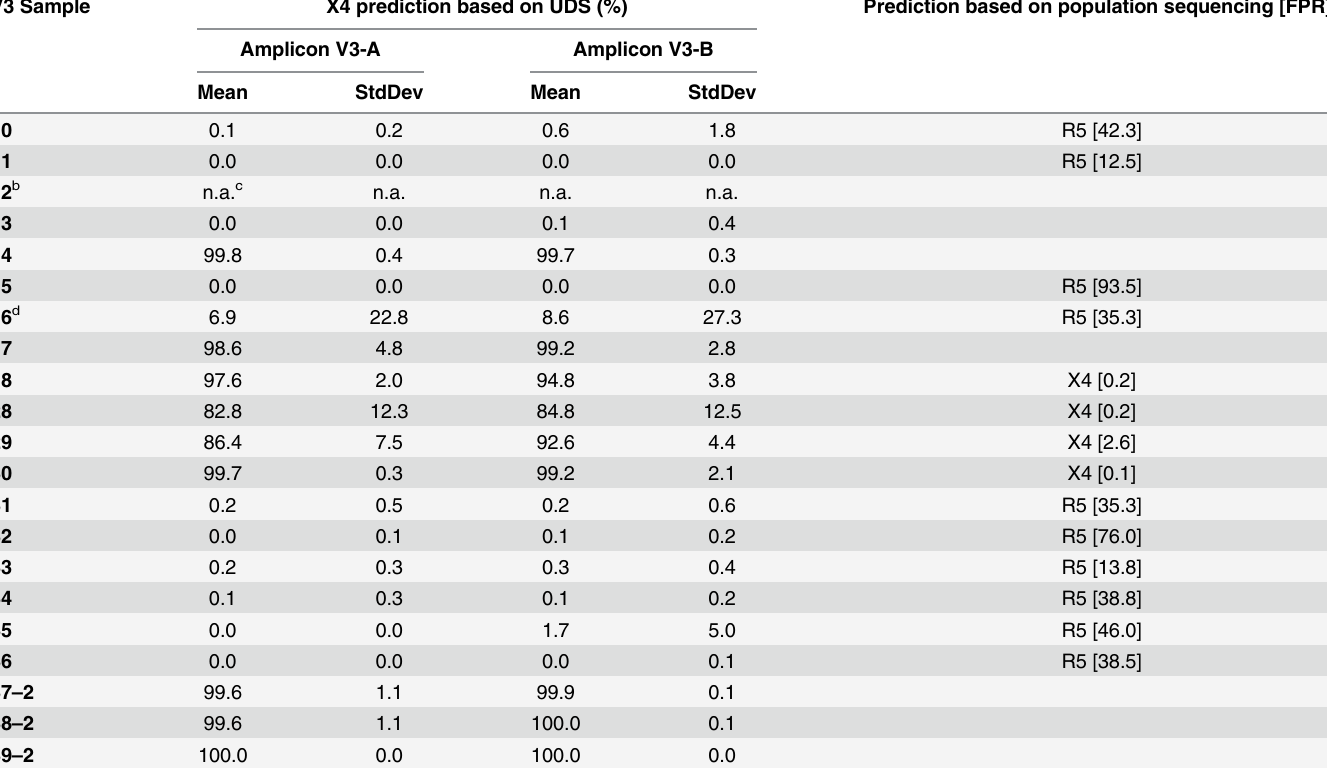
Table 5. Co-receptor usage predictions. Calculations for UDS were performed using geno2pheno with a false positive rate setting of 3.75% and reported as means with standard deviations for each sample across all sites.